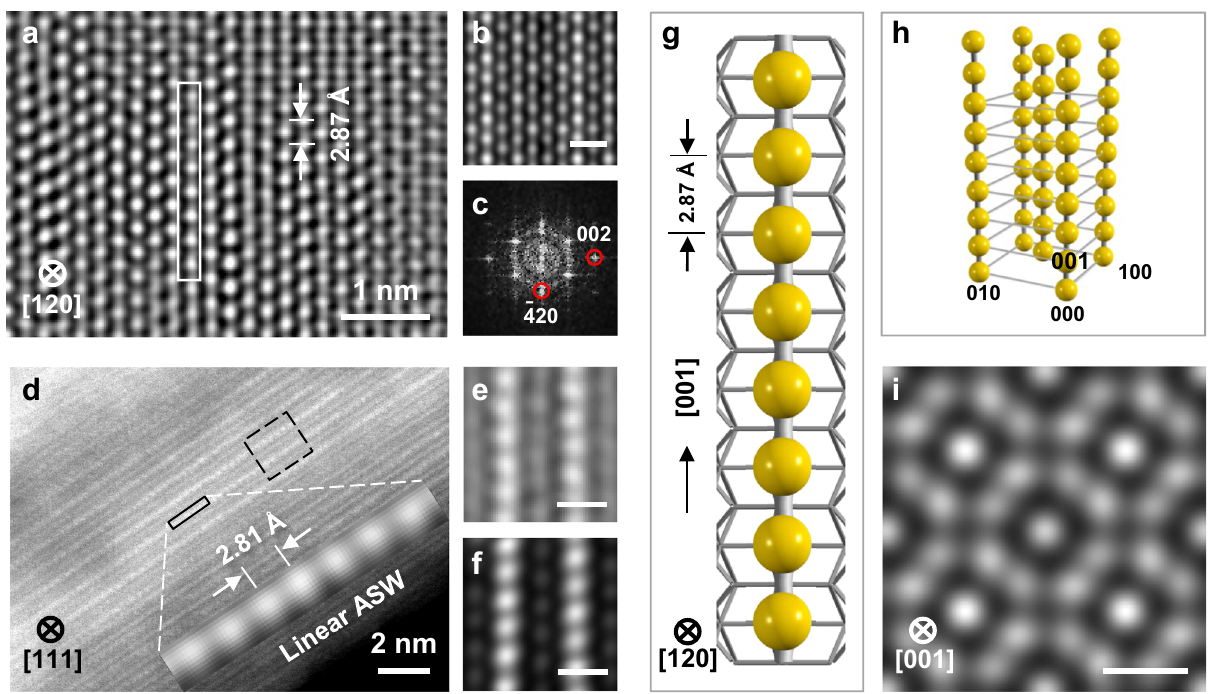
Fig. 2 Electron microscopy imaging and structure models of ASWs. a , b Filtered and simulated HRTEM images viewed from a α -MnO 2 [120] axis. c Calculated diffraction pattern from a . d HAADF-STEM image, viewed from the α -MnO 2 [111] direction (the inset shows an enlarged linear Ag wire after Fourier fi ltering). e , f Filtered and simulated images enlarged from the black dashed rectangle in d . g Structural model of one typical ASW together with the α -MnO fi ve ASWs. i Simulated image of ASWs in the α -MnO 2 framework. h 3D model of the array with 2 tunnels viewed from the [001] direction showing the inter-wire distance. Scale bars in b , e , f , and i , 0.5